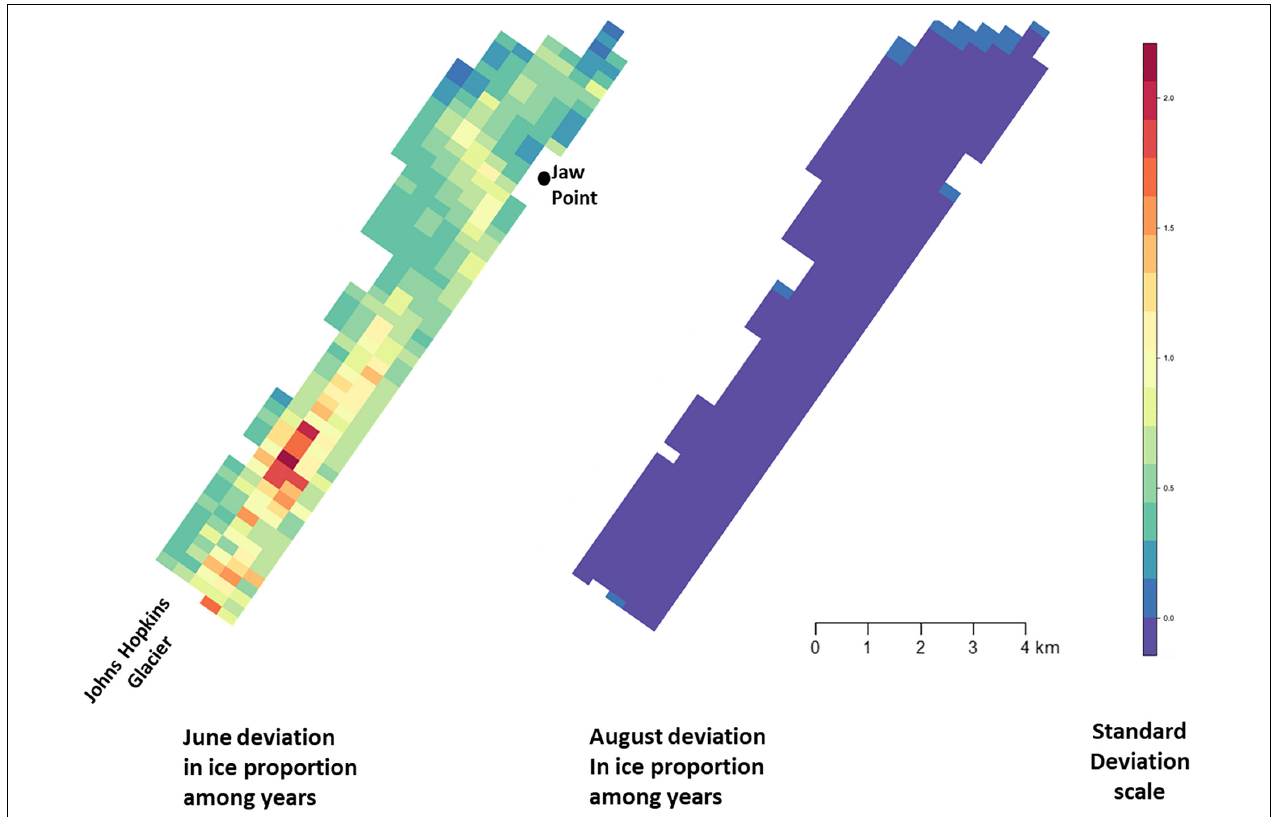
FIGURE 6 | Standard deviation of ice proportion data collected in Johns Hopkins Inlet in Glacier Bay National Park in southeastern Alaska during June (left panel) and August (right panel) from 2007 to 2014. Grid cell size is 200 m × 300